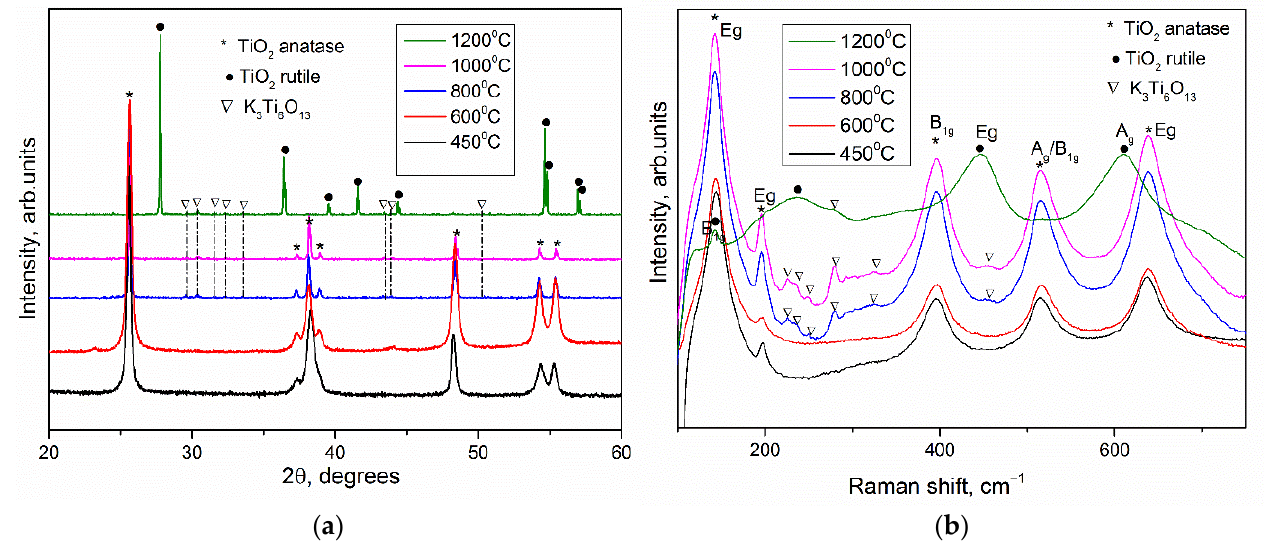
Figure 3. ( a ) XRD Patterns and ( b ) Raman spectra of TiO 2 obtained by heat treatment of ammonium oxofluorotitanate after 450, 600, 800, 1000 and 1200 °C for 2 h. Phases identity as K 2 Ti 6 O 13 (PDF #13 − 0447), anatase TiO 2 (PDF #21 − 1272), TiO 2 rutile (PDF #21 − 1276).